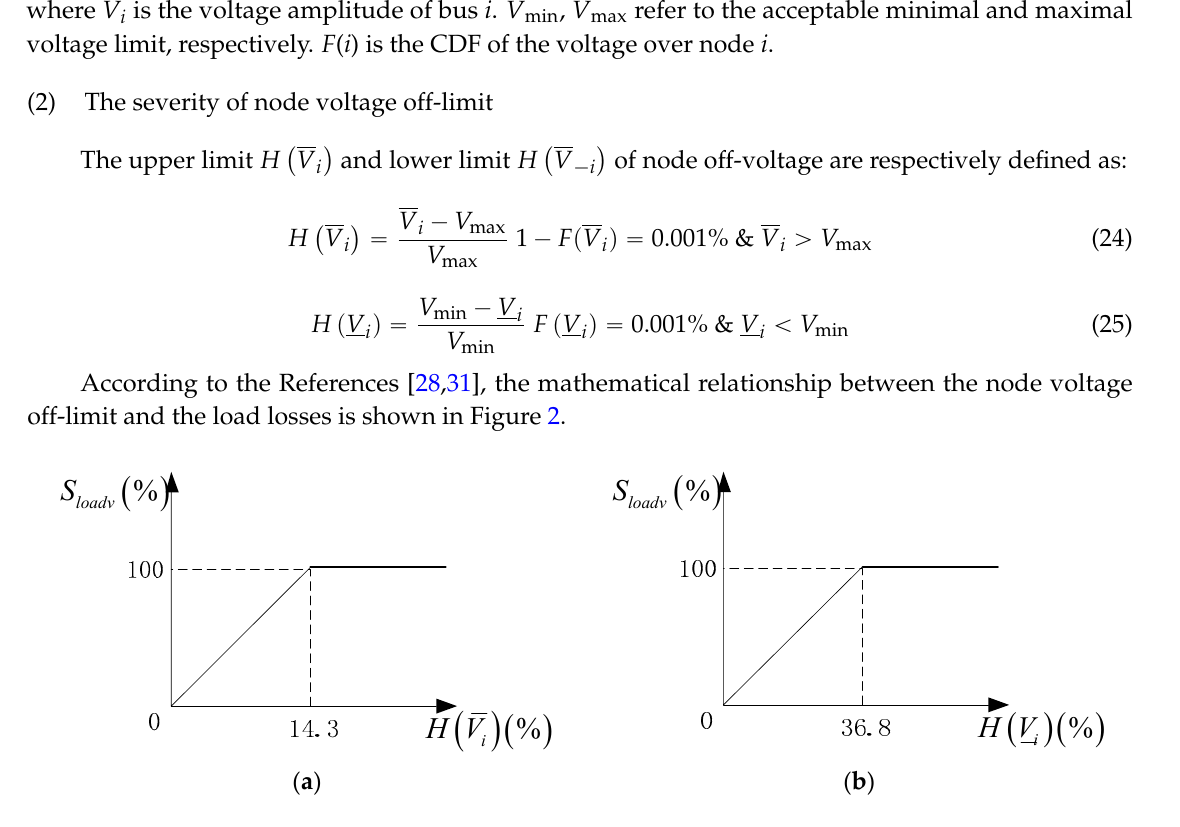
Figure 2. ( a ) Mathematical relationship between the load losses and the voltage over upper limit; ( b ) Mathematical relationship between the load losses and the voltage below lower